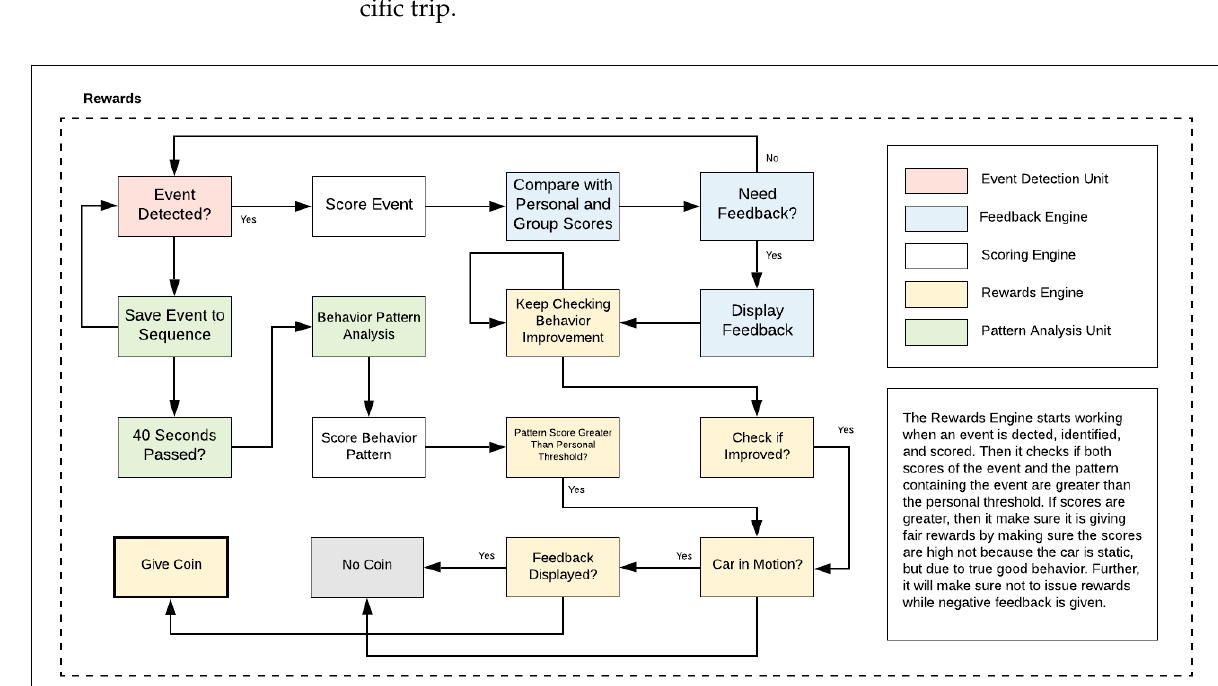
Figure 6. Rewards engine diagram.